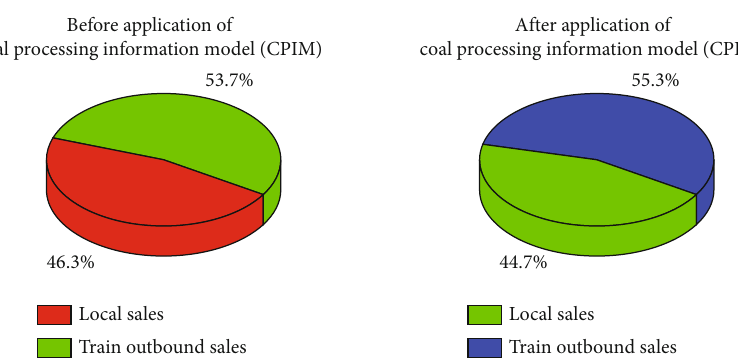
Figure 12: Variation of sales comparison for clean coal due to application of Coal Processing Information Model (CPIM).